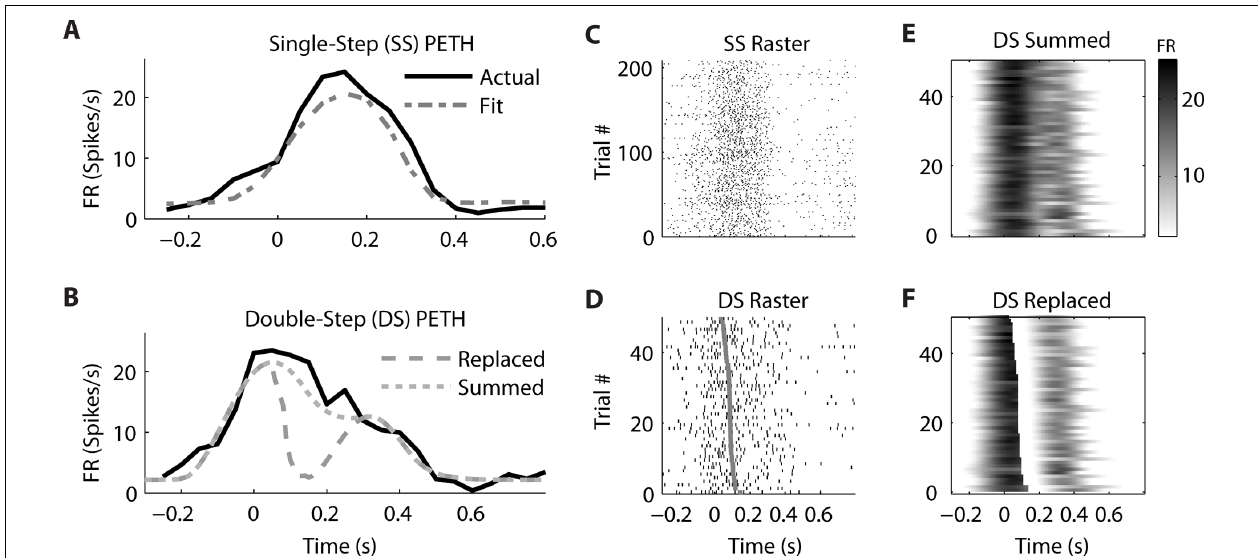
“Replaced” prediction (gray dashed). Zero time refers to the time of the target jump. (C) The single-trial spike time rasters for the SS trials. (D) The single-trial spike time rasters for the DS trials, arranged by the predicted replacement time (gray). (E) The DS single-trial prediction of the “Summed” hypothesis, displayed as a heat map. (F) The DS single-trial prediction of the “Replaced” hypothesis.